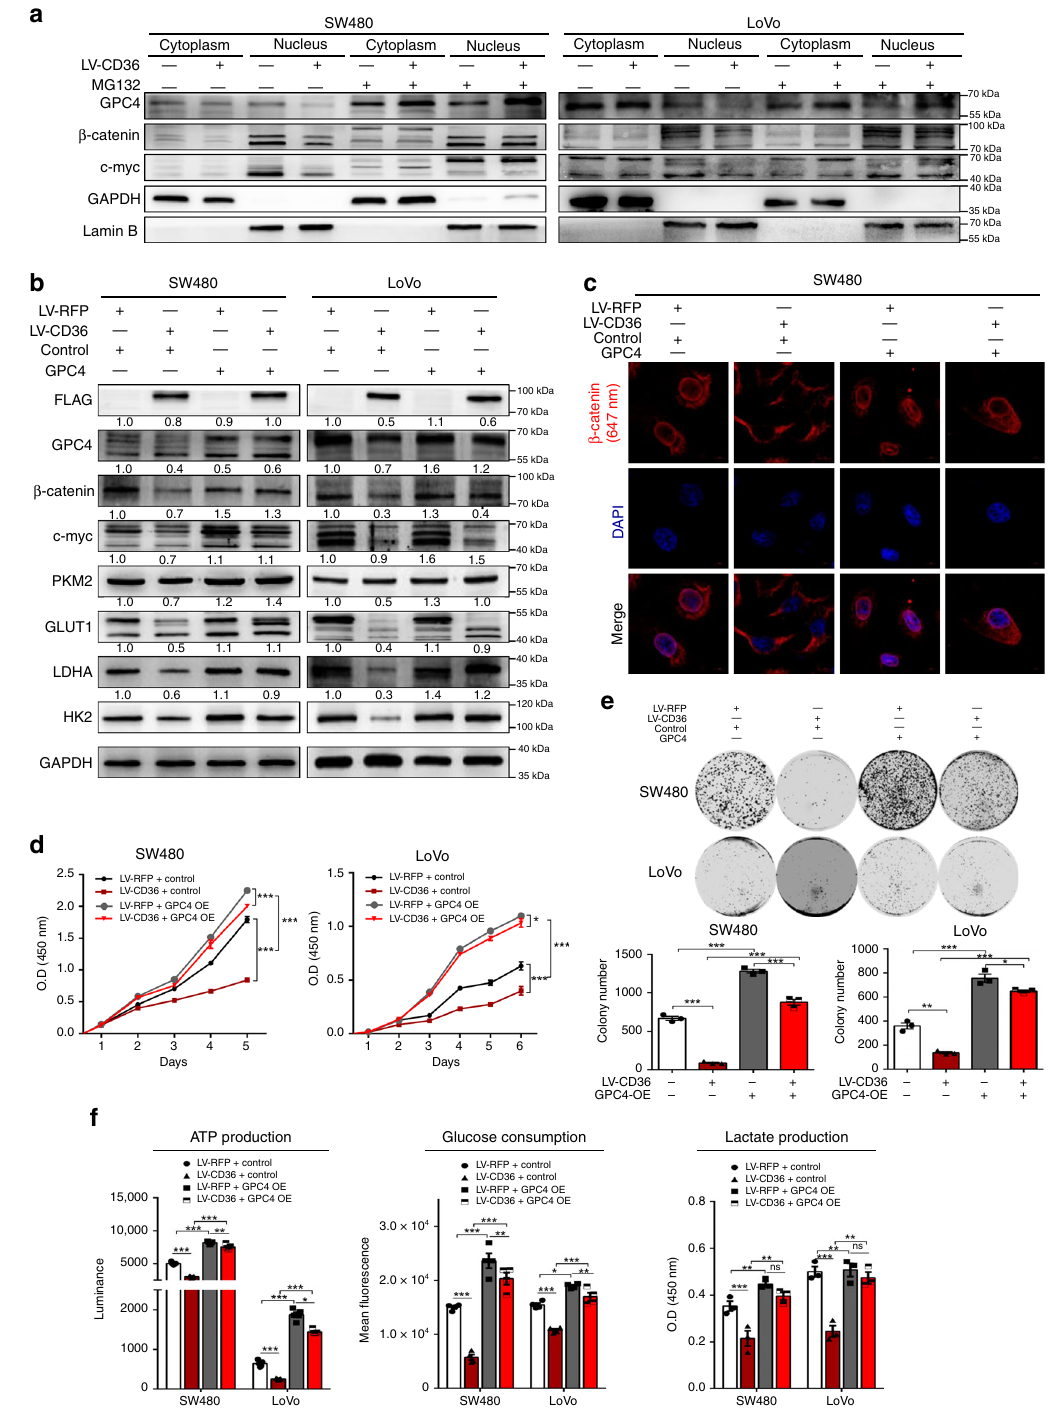
Fig. 5 The functional role of CD36 is dependent on GPC4. a Western blot of indicated proteins with/without MG132 treatment. Lamin B is a nuclear marker, GAPDH was loaded as a cytoplasmic marker. b Western blots of indicated proteins in SW480 and LoVo cells (LV-RFP vs. LV-CD36) with/without ectopic expression of GPC4. c IF analysis of β -catenin (red) location after forced expression of GPC4. d CCK8 tests. e Colony formation assays. f ATP production (left), glucose consumption (middle) and lactate production (right). Each experiment was performed in at least triplicate and results are presented as mean ± SEM. Student ’ s t -test or two-way ANOVA was used to analyze the data (* P < .05, ** P < .01, *** P < .001, **** P < .0001). Source data are provided as a Source Data fi